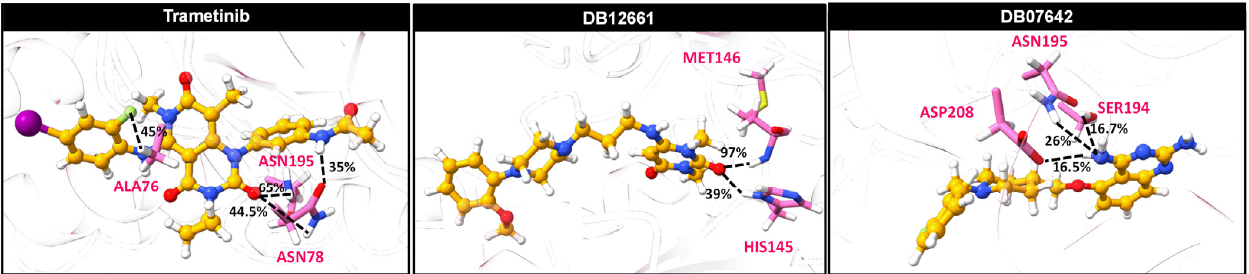
Figure 4. Percentage of hydrogen bond occupations contributing to the binding of two screened compounds (DB12661 and DB07642) and the trametinib within the ATPase domain of MEK1 using two criteria involving the distance and angle between the hydrogen bond donor (HD) and hydrogen acceptor (HA) of ≤ 3.5 Å for the distance and ≥ 120° for the angle, respectively.